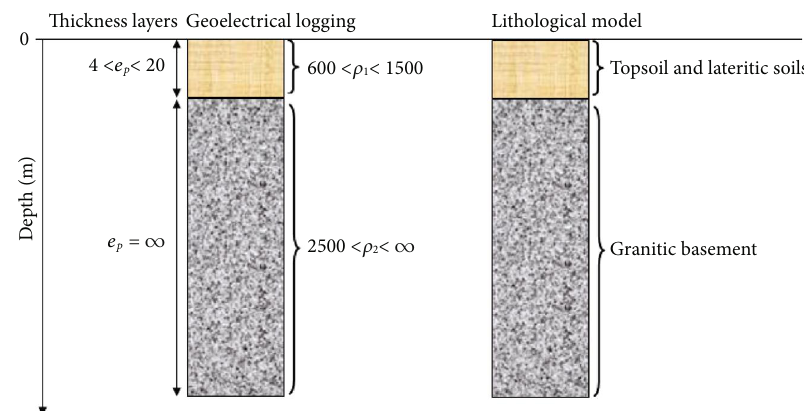
Figure 19: Lithological model of sounding curves of type G.